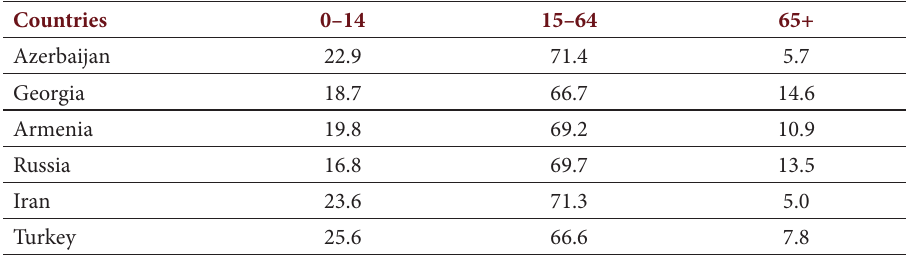
Table 3. Population of Azerbaijan and bordering countries by age groups in 2015,%.